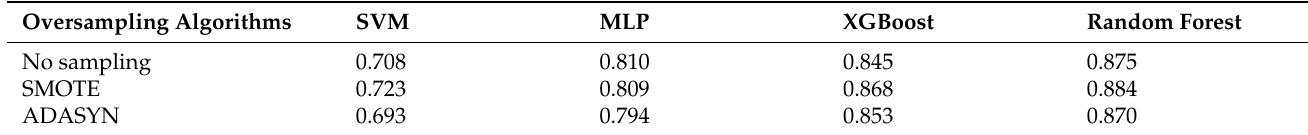
Table 2. Comparison of the performances of oversampling